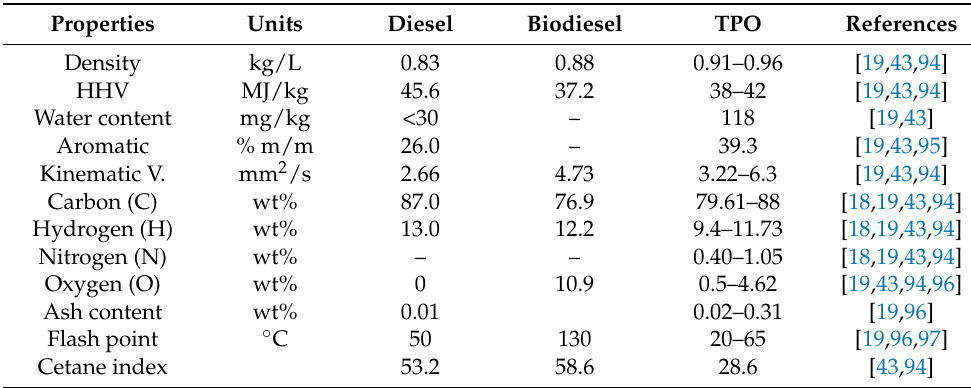
Table 2. Physicochemical properties of tyre oil, WCBD and